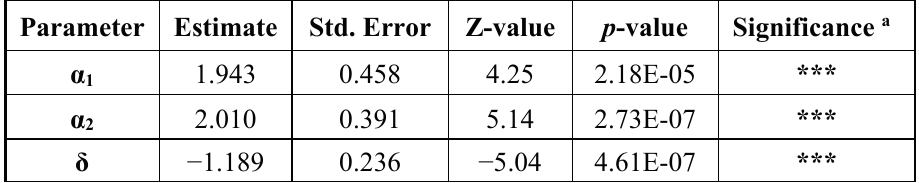
Table 6. Systematic shift and interactive